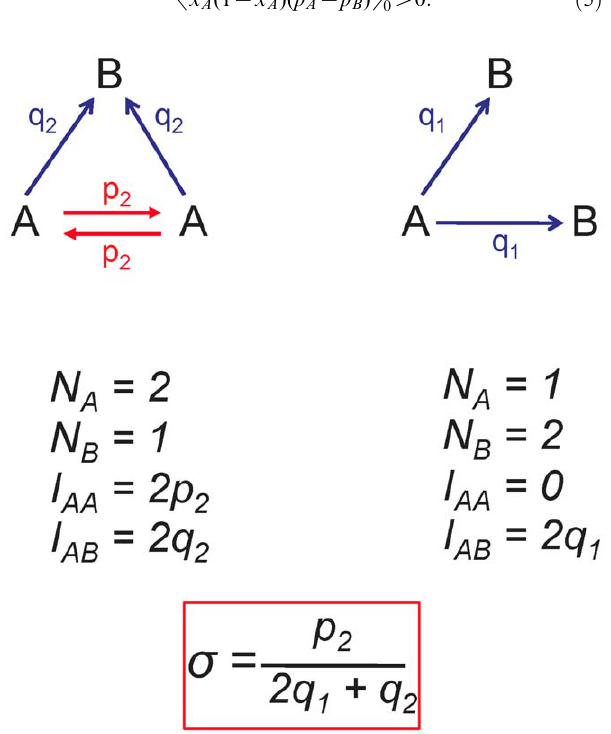
Figure 1. Calculation of s for a very simple example with population size N ~~ 3 . Suppose there is a ‘spatial’ process which has two mixed states. These two states must have the same frequency in the stationary distribution at neutrality, because the process cannot introduce asymmetries between A and B at neutrality. Each mixed state can be described by a weighted, directed graph: in a state with i A players, let p i be the probability that an A plays with another A and let q i be the probability that an A plays with a B . These probabilities are enough since for the calculation of s we only need the AA edges and the AB edges. Note also that the pure states, all- A and all- B , do not contribute to the calculation. We obtain s ~ p 2 = (2 q 1 z q 2 )